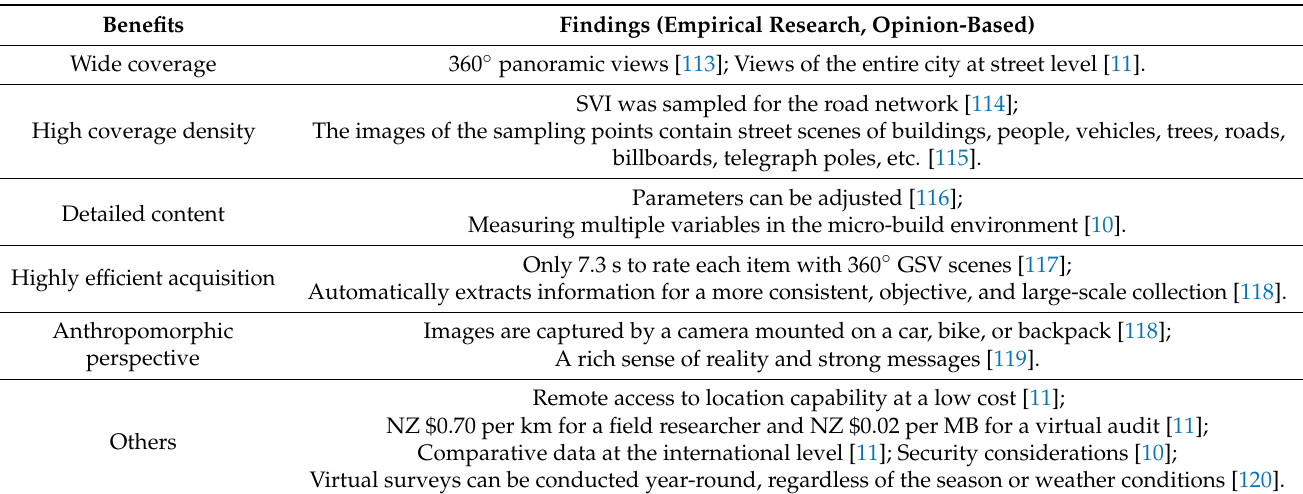
Table 4. Summary of the perceived benefits of SVI in the built